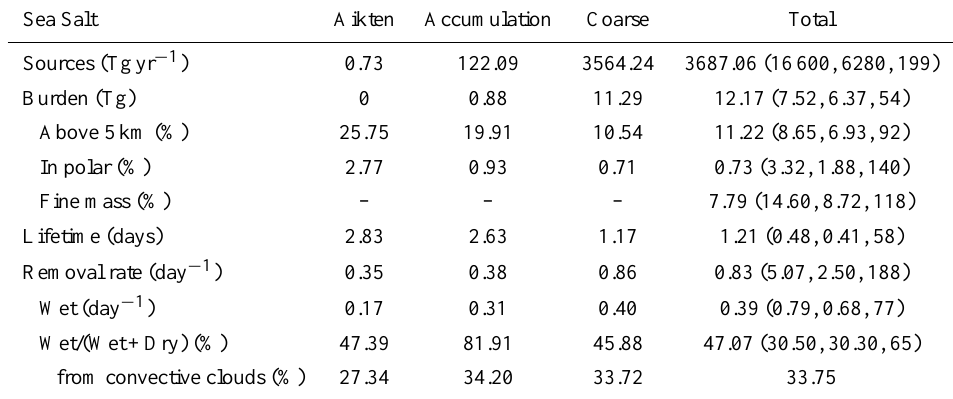
Table 6. Global annual budget for sea salt. The values in the parenthesis are the mean (left), median value (middle), and standard deviation (right) from available models in AeroCOM (see Textor et al., 2006, Table 10). The standard deviation is normalized by the all models average in the percentage in